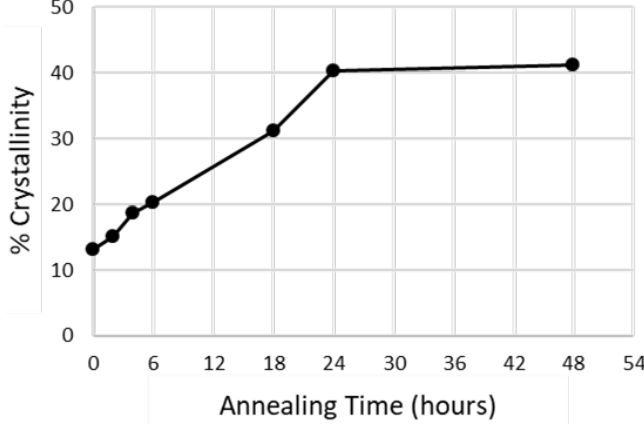
Figure 3. Change in crystallinity Poly- L -lactic acid (PLLA) Extruded tubing annealed at 70 °C as a function of annealing time.